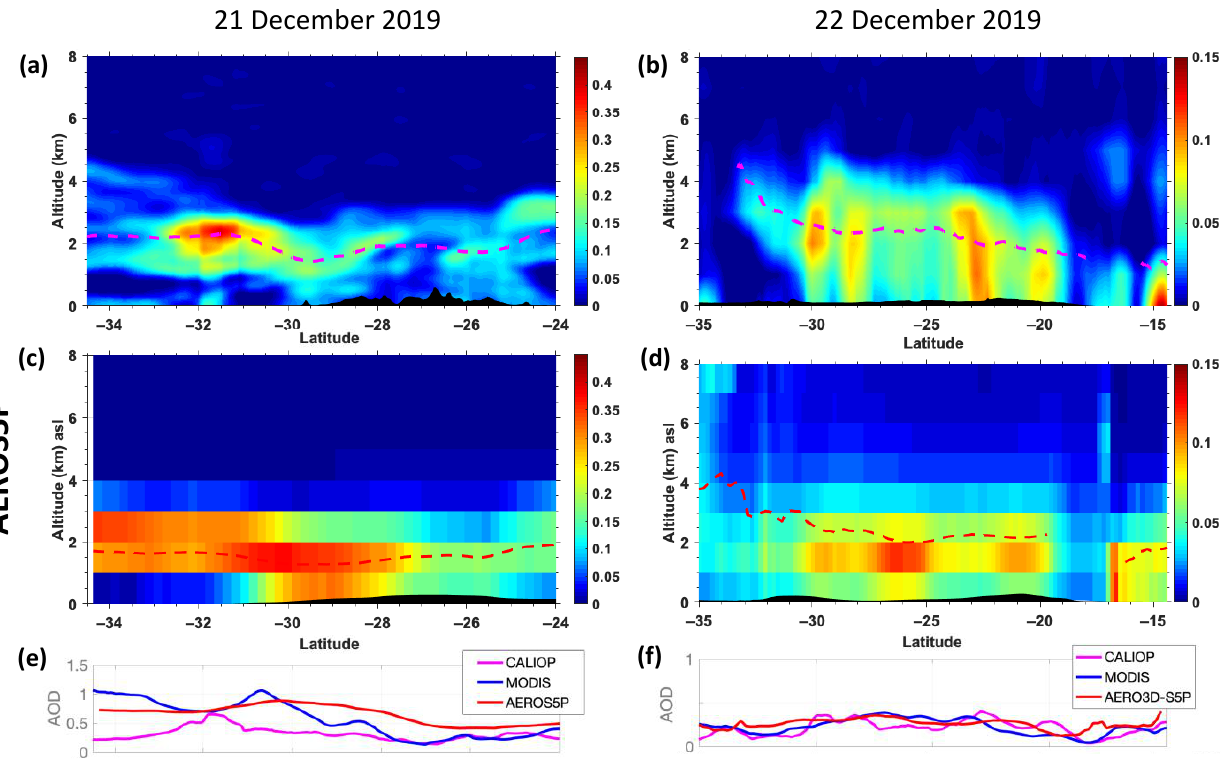
Figure 5. Comparison of transects of aerosol extinction profiles (in km − 1 ) derived from ( a , b ) the CALIOP spaceborne lidar and ( c , d ) the AEROS5P passive approach on ( a , c ) 21 December and ( b , d ) 22 December 2019. Dashed lines indicate the mean altitude of the aerosol layers defined as the ones with half of the AOD above and below. The corresponding AOD at 550 nm from MODIS MAIAC and AEROS5P, and CALIOP at 532 nm is shown in panels ( e , f ).